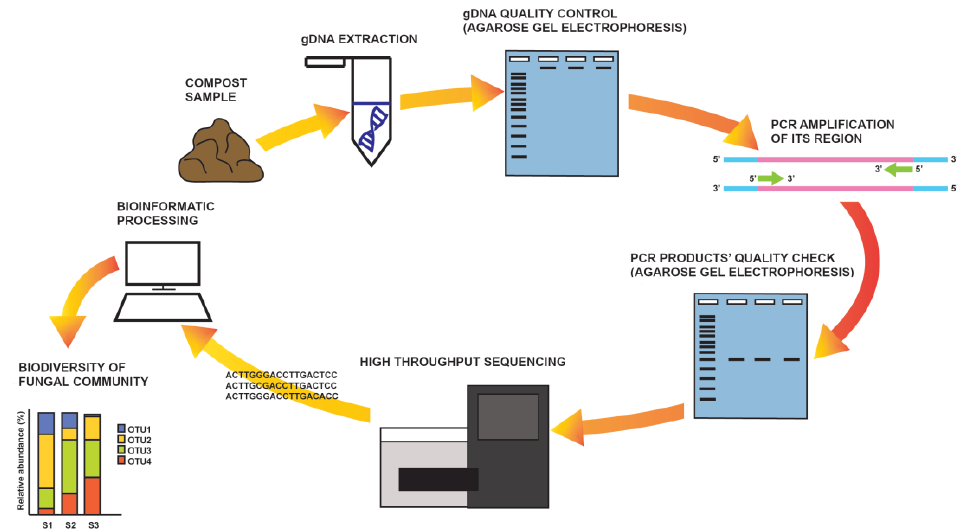
Figure 1. DNA metabarcoding — schematic representation of a workflow.